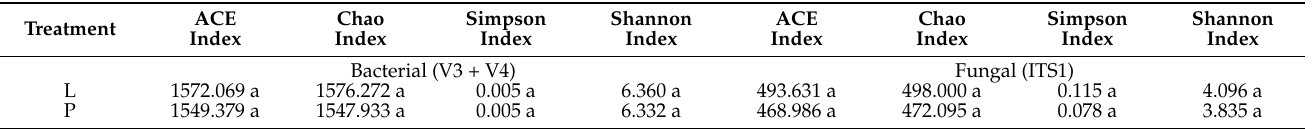
Table 6. The abundance and diversity of operational taxonomic units from soil samples.